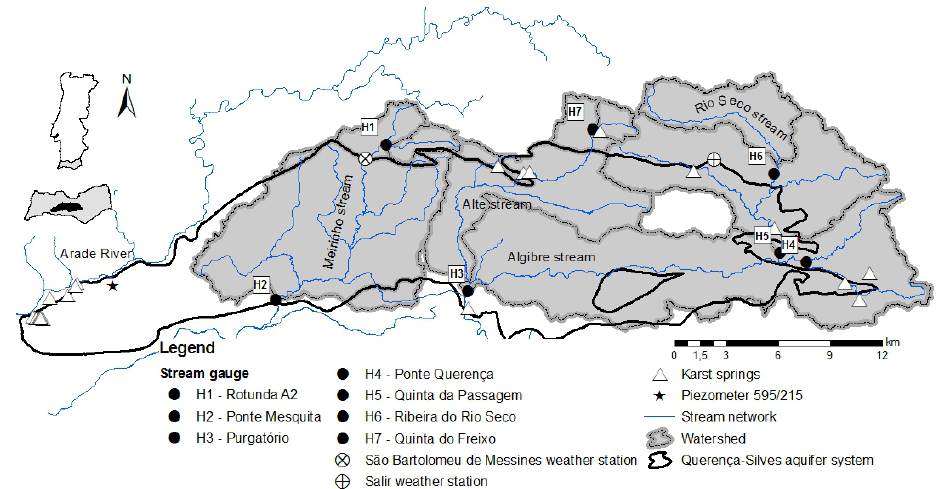
Fig. 1. Location of study area, characterising the surface–groundwater relationships; also shown is the location of the stream gauges, weather stations, piezometer 595/215 and